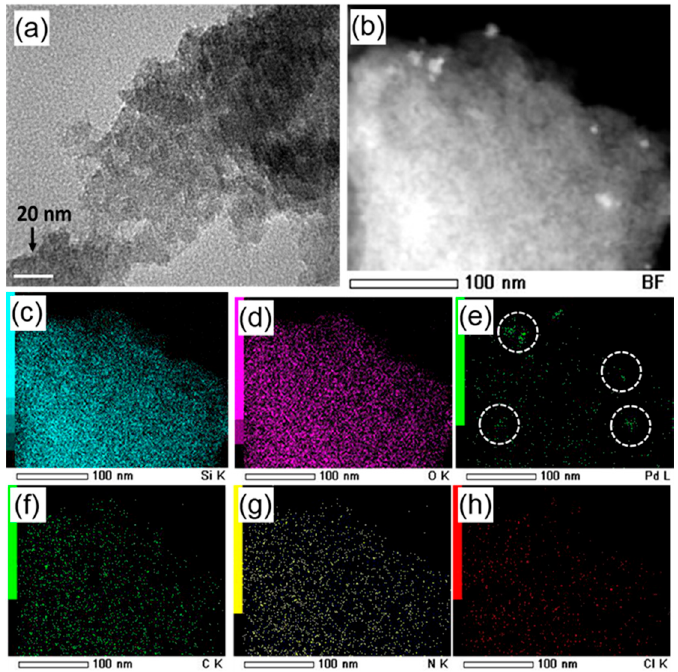
Figure 2. Pd@Bipy–PMO: ( a ) TEM, ( b ) high-angle annular dark-field scanning transmission electron microscopy (HAADF–STEM), and ( c – h ) energy–dispersive X–ray spectroscopy (EDX)-mapping images. Catalysts 2019 , 9 , x FOR PEER REVIEW